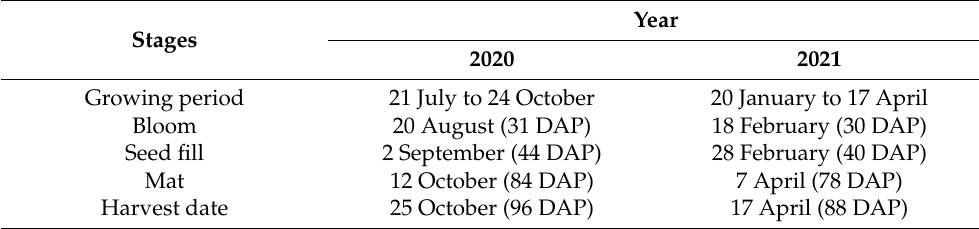
Table 6. Growth stages of soybean crop in 2020 and 2021.